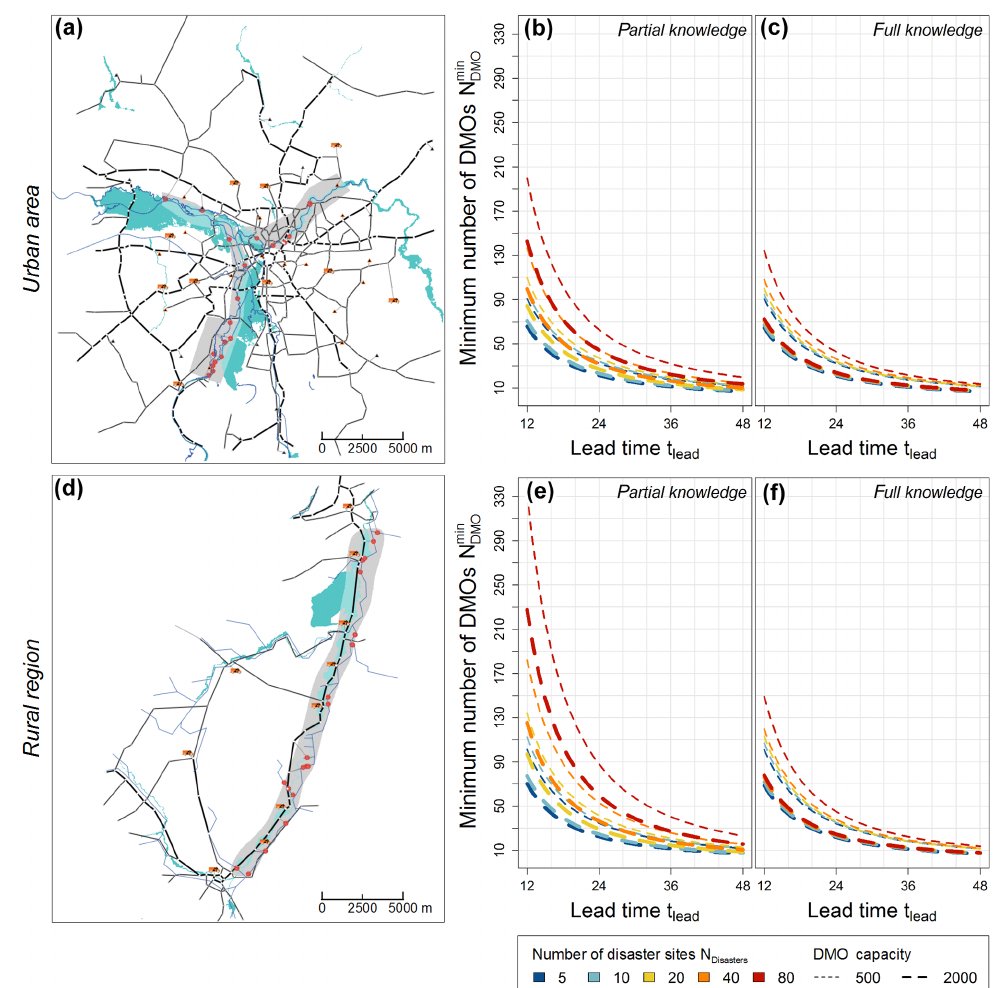
Figure 8. Minimum number of DMOs N min in depending on the flood lead time t lead . The results are depicted for two spatial settings, an DMO urban area (a–c) and a rural region (d–f) . The maps for each region (a, d) show rivers (blue lines), flood-prone areas (blue shaded area) and the transportation network (black and grey lines). The lines in the main graphs ( b , c and e , f ) are color-coded according to the number of disaster sites and their thickness shows the transportation capacity of the DMO